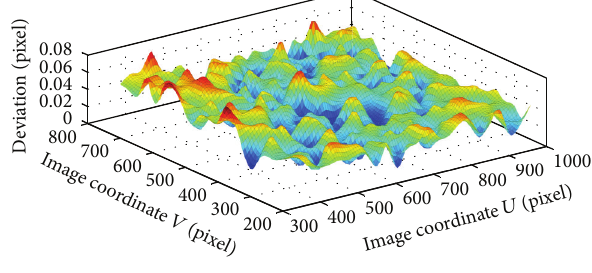
Figure 6: Deviation surface after correction.